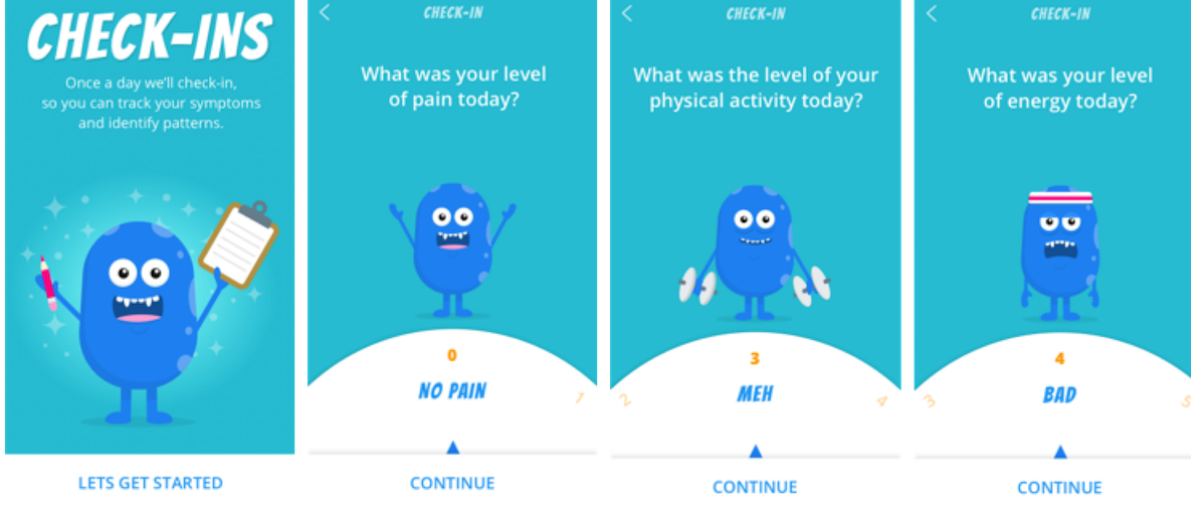
Figure 1. Example screenshots of the iCanCope daily symptom Check-in. From left: introductory screen; lowest anchor of pain intensity scale; mid-anchor of physical; activity scale; high-anchor of energy scale.